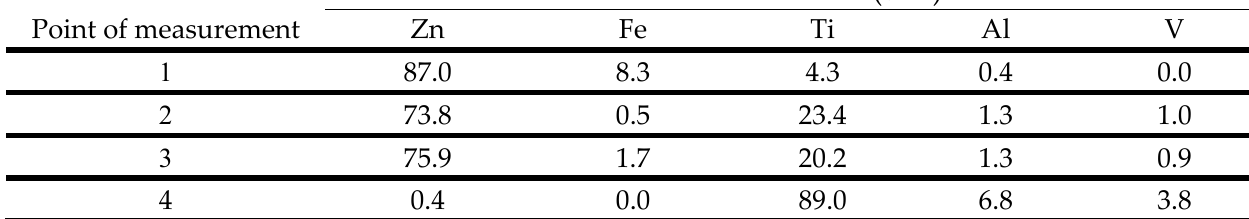
Figure 4. Spot chemical composition measurements along the border obtained by EDS analysis with an error of 2%at.